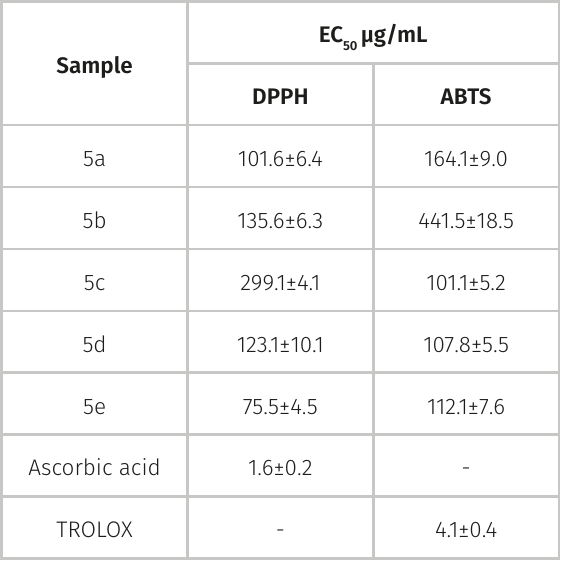
Table I. Antioxidant activity of compounds 5a-e.